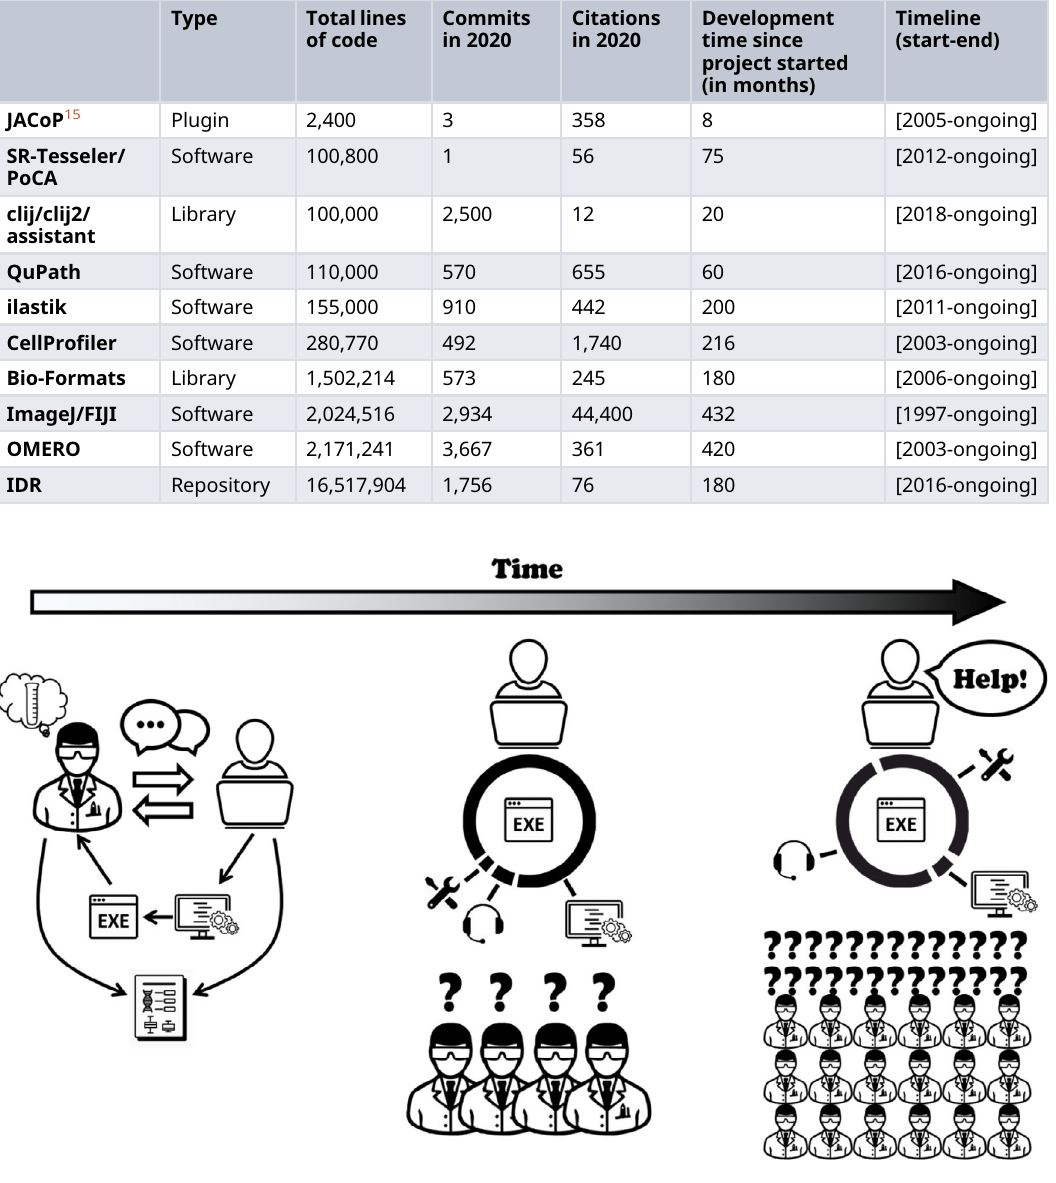
Figure 1. Lifetime of an open-source software. Created to solve a biological analysis need, the tool is released and published. As it is adopted by new users, the developer begins to spend time on user support and maintenance, while still managing to add new methods. Finally, as the number of users continues to grow, the developer is over- whelmed with user support and maintenance. As this stage, securing funding for new dedicated developers is